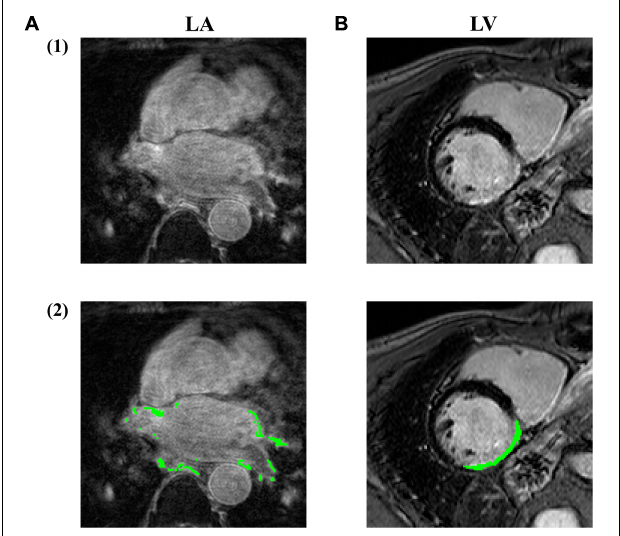
FIGURE 2 | Examples of LGE CMR images acquired at (A) LA and (B) LV, with the fibrosis/infarction regions highlighted in green. By comparing (A2) and (B2) , we can see the fibrosis region in LA is rather more discrete and thinner compared to LV infarction, making LA fibrosis regions more difficult to be accurately fully localized and quantified. Image source: (A) was extracted from pre-ablation CMR images in ISBI 2013 cDERMIS dataset (http://www.cardia catlas.org/challenges/left-atrium-fibrosis-and-scar-segmentation-challenge/). (B) was extracted from MICCAI 2012 Ventricular Infarct Segmentation challenge dataset (http://www.cardiacatlas.org/challenges/ventricular-infarct -segmentation/).